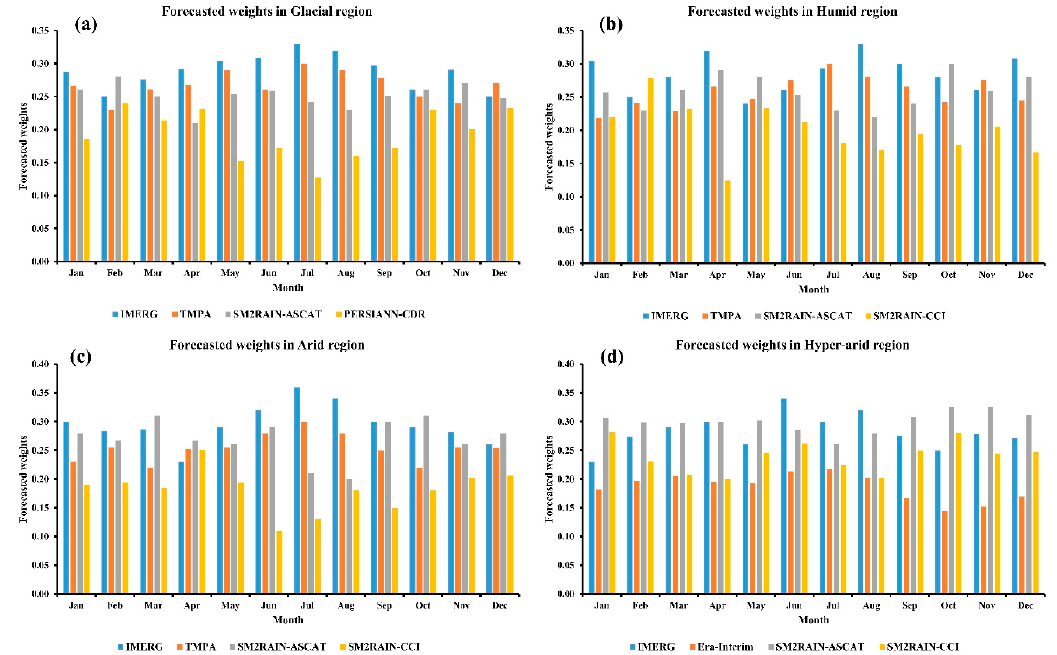
Figure 9. Temporal distribution of ARIMA forecasted weights on a monthly scale across the regions. ( a ) Glacial; ( b ) Humid; ( c ) Arid; ( d ) Hyper-arid.